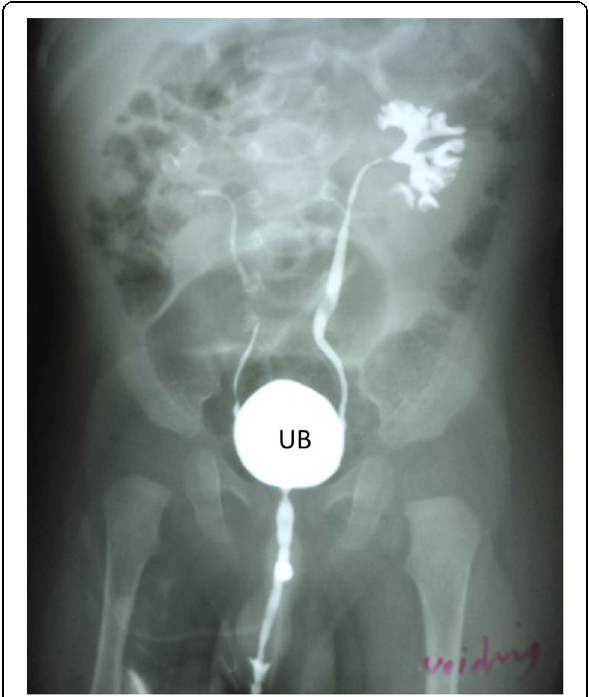
Fig. 17 Vesico-ureteric reflux in a neonate. A voiding cysto-urethrogram image showing bilateral vesico-ureteric reflux, more on the left side